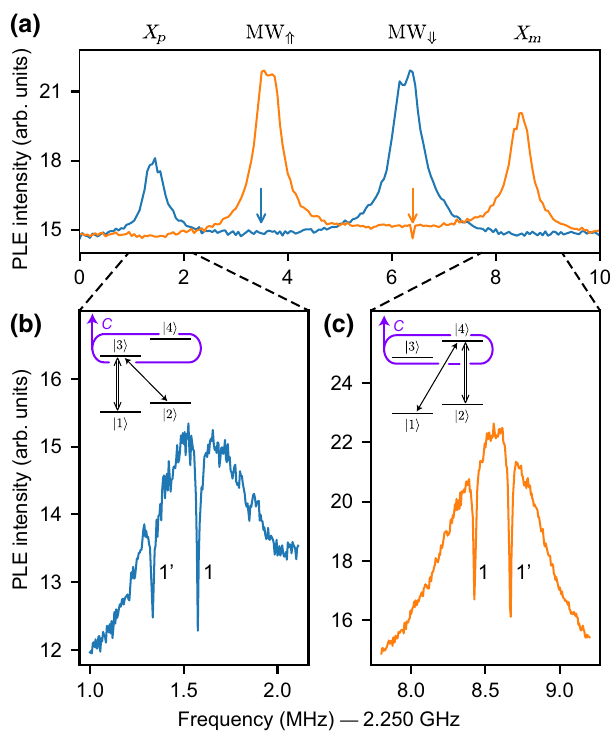
FIG. 3. ODMR spectra showing the sideband photolumines- cence as a function of MW probe detuning. Resonant optical excitation of TX 0 C provides electron-spin-selective readout from |↑ e (cid:6) . (a) Two of the four resonances MW ⇑ , MW ⇓ , X p , and X m are visible depending on the configuration of a MW pump (pump frequency arrow matches the corresponding spectrum color). The outer resonances are MW (cid:4) configurations. (b),(c) High-resolution ODMR spectra of the (cid:4) resonances showing narrow CPT dips at two-photon resonance for each of the 1 and 1 (cid:7) orientation subensembles. The insets show energy level schemes showing the corresponding optical and MW